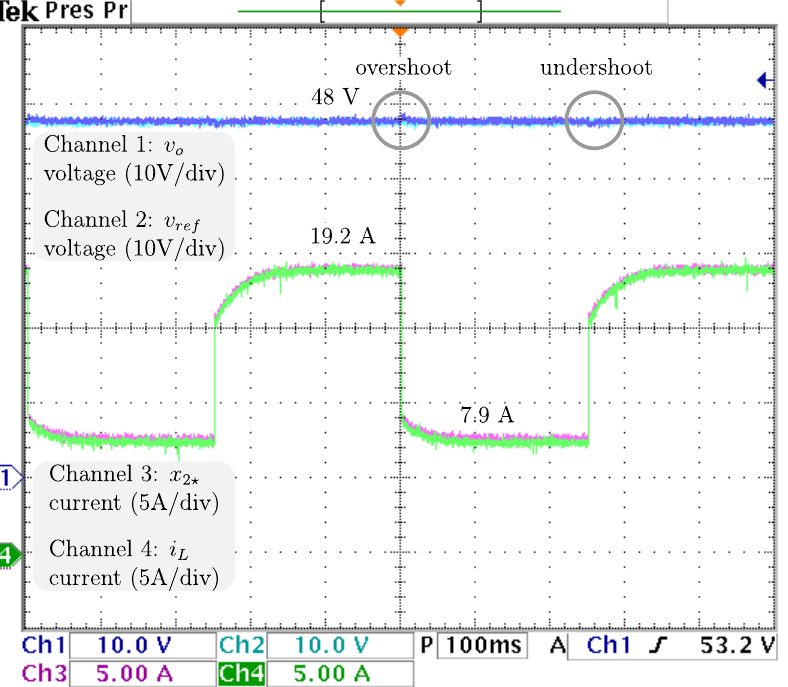
Figure 6. Real -time results for sudden load changes. From top to bottom: v o , the output voltage; v ref , the reference voltage; x 2 (cid:63) , the inductor current reference; and i L , the inductor current.